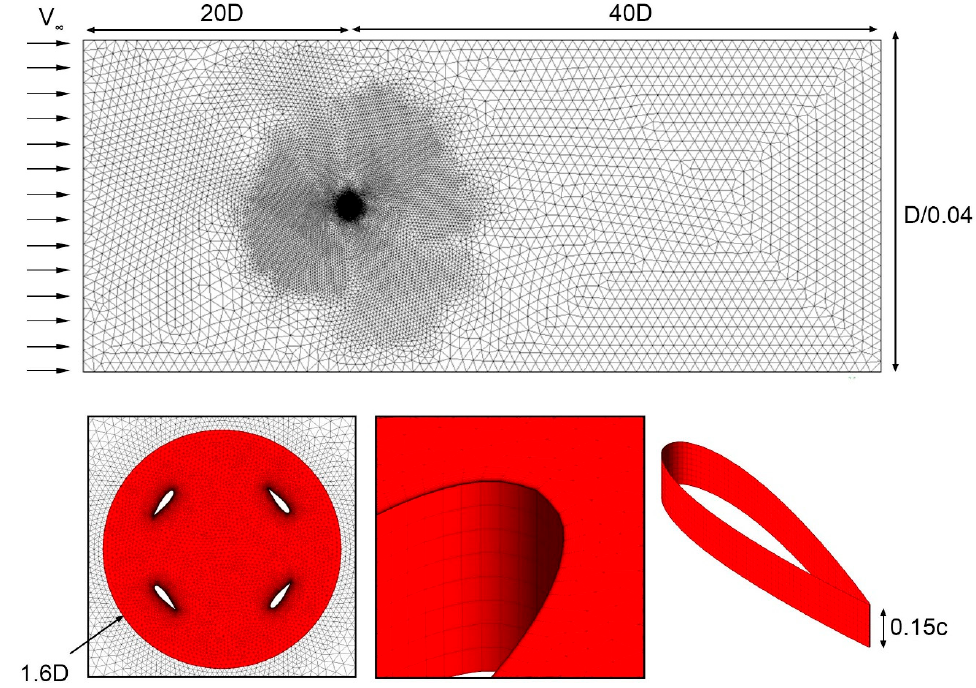
Figure 4. The 2.5D computational domain with the rotor zone shown in red.